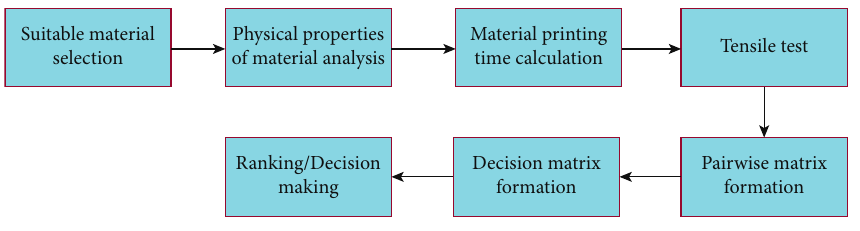
Figure 2: Research fl ow of the paper. Table 1: Saaty scale of relative alternative,